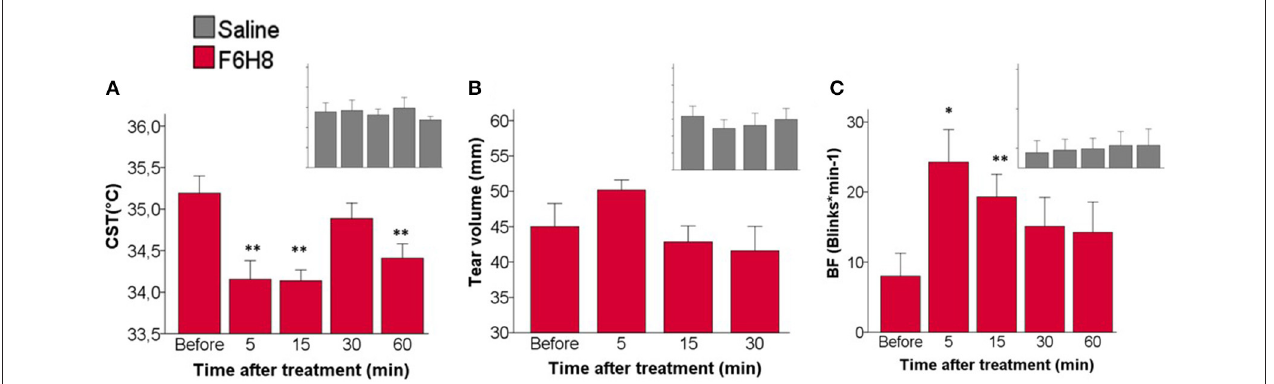
FIGURE 3 | Effects of topical instillation of F6H8 (red) or saline solution (insets in gray) on both eyes. (A) CST at the beginning of the last interblink interval measured from infrared thermographic images, p = 0.001, Repeated Measurements ANOVA; ** p < 0.01 Dunnett’s test n = 7. (B) Tear volume measured with phenol red threads, no significant differences, Repeated Measurements ANOVA, n = 6. (C) Blinking frequency (BF), p < 0.005, Repeated Measurements ANOVA; * p < 0.05, ** p < 0.01, Dunnett’s test, n = 7.